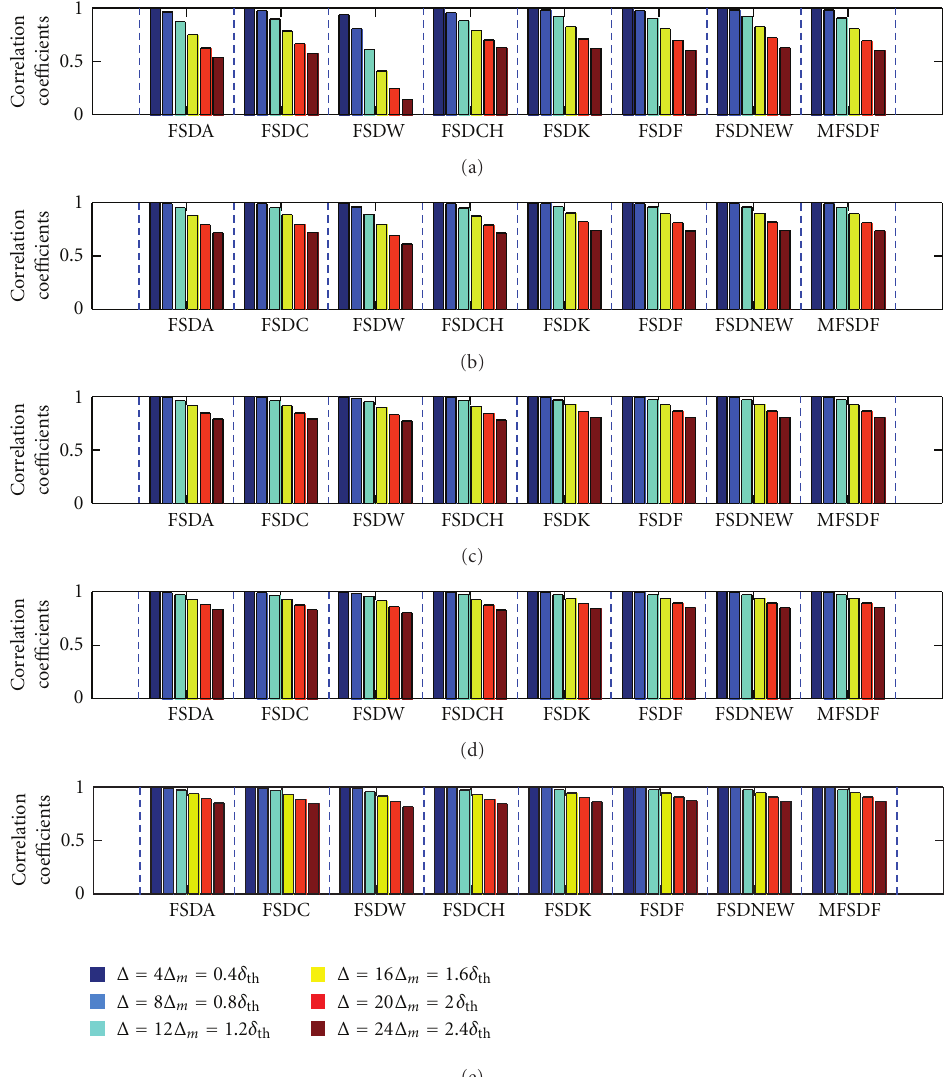
Figure 8: Correlation coe ffi cients between the modelled and the actual values of Σ gen in the c range 0 . 1 ≤ c ≤ 0 . 9 for filter widths Δ = 4 Δ m = 0 . 4 δ th ; Δ = 8 Δ m = 0 . 8 δ th ; Δ = 12 Δ m = 1 . 2 δ th ; Δ = 16 Δ m = 1 . 6 δ th ; Δ = 20 Δ m = 2 . 0 δ th ; Δ = 24 Δ m = 2 . 4 δ th for (a–e) cases